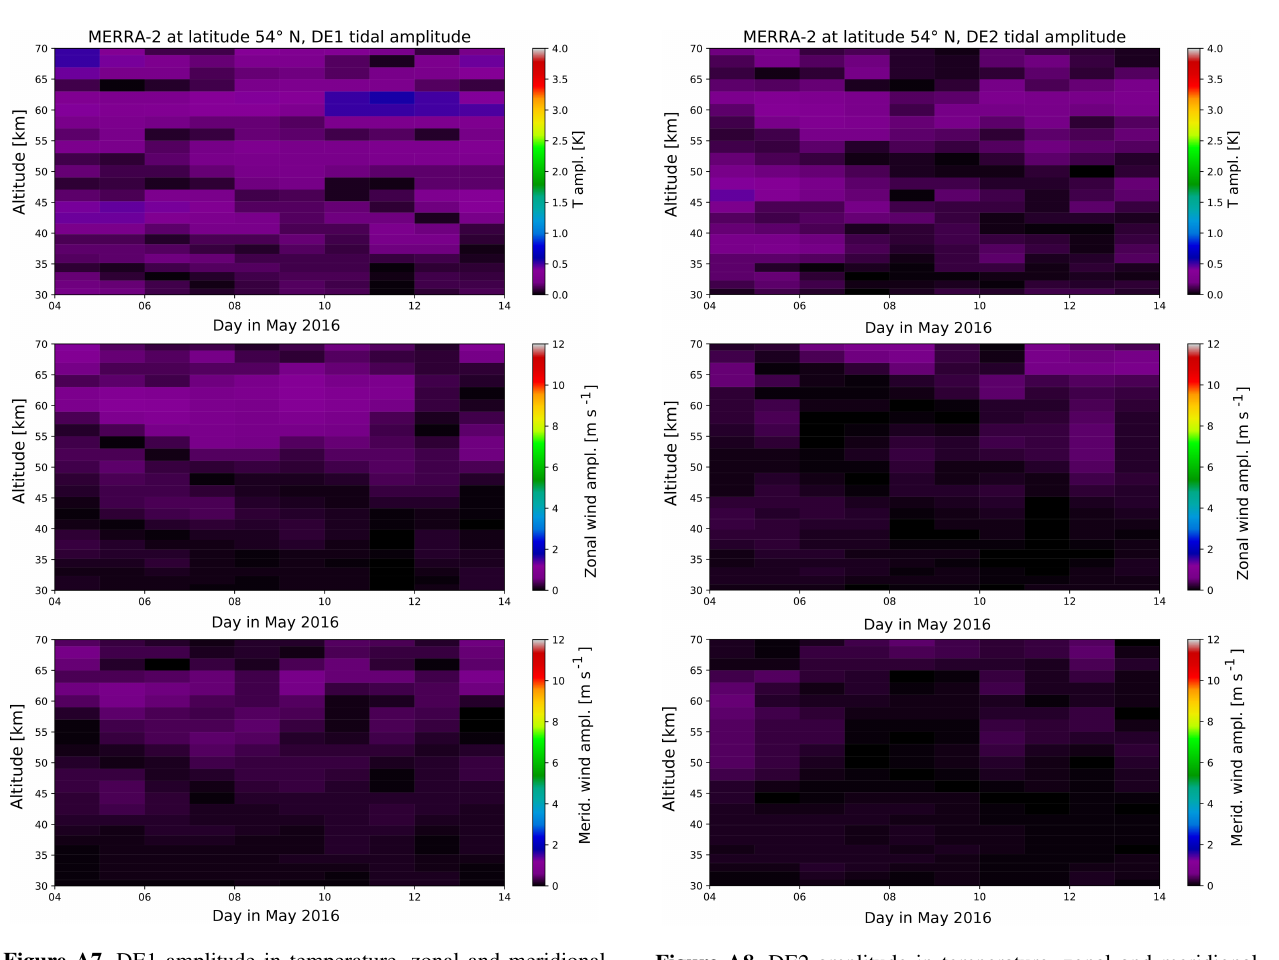
Figure A8. DE2 amplitude in temperature, zonal and meridional wind from global MERRA-2 fields at the latitude of 54 ◦